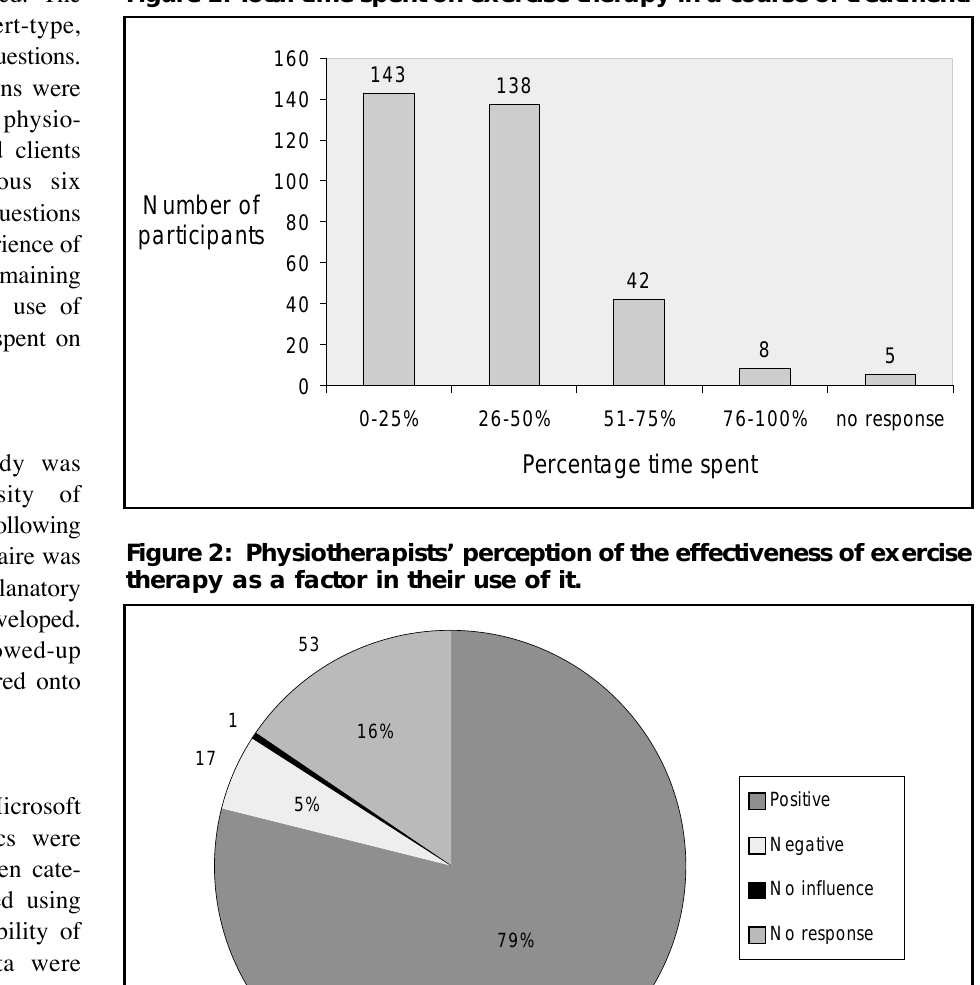
Figure 1: Total time spent on exercise therapy in a course of treatment.